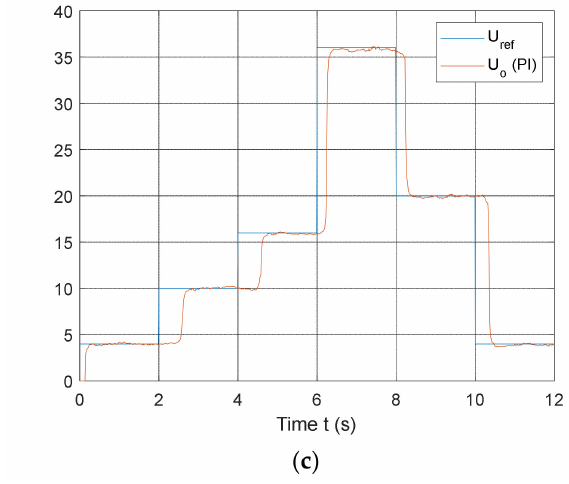
Figure 12. Output voltage control: ( a ) using P controller, ( b ) using I controller, ( c ) using PI controller.